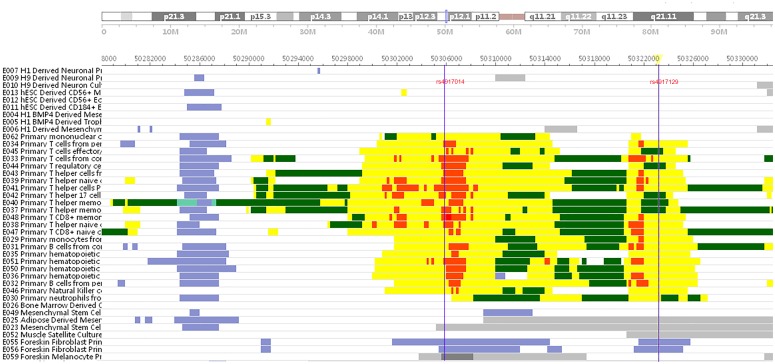
Chromatin states of the rs4917129 locus in different cell lines and tissues.This figure was plotted according to the core-15 states model from the Roadmap Epigenetic project[22]. The majority of samples used in this analysis were immune-related cell lines or tissues, with several other cell lines or tissues as controls. Chromatin states are denoted with different colors; in particular, yellow indicates an enhancer chromatin state.